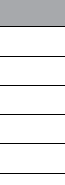
Table 1. List of known-BAT genes. See Supplementary Appendix S1 for full gene names and details about the literature search performed to generate this